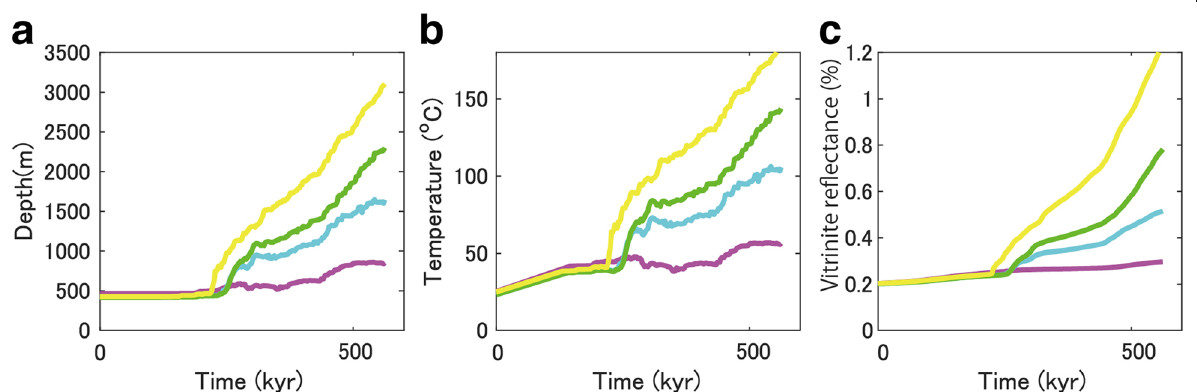
Fig. 4 The depth ( a ), temperature ( b ), and vitrinite reflectance ( c ) vs. the time of the target particles. The colors of the lines correspond to the colors of the particle in Fig.